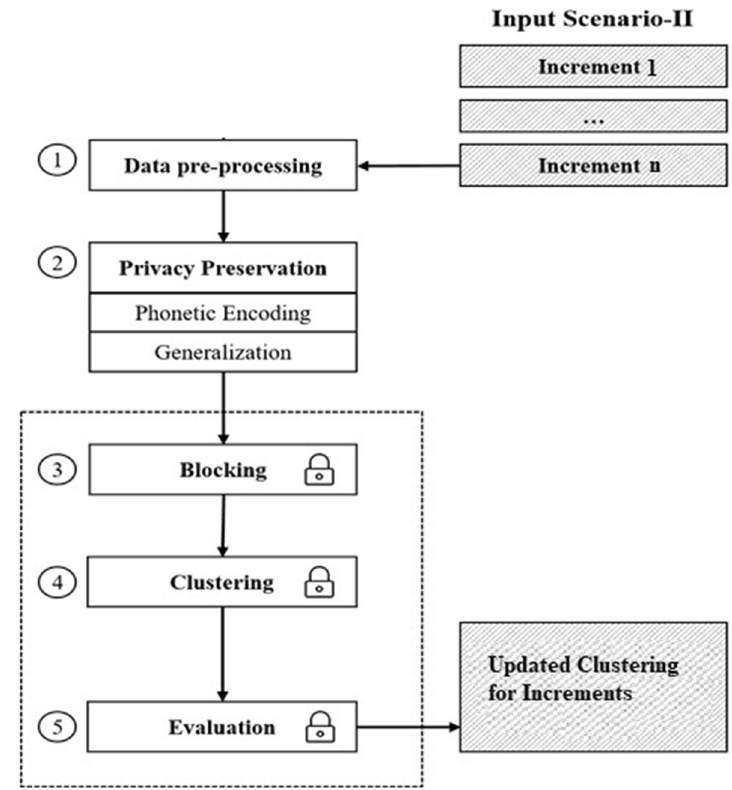
Fig. 6 PPIRL, an end-to-end framework steps for increments